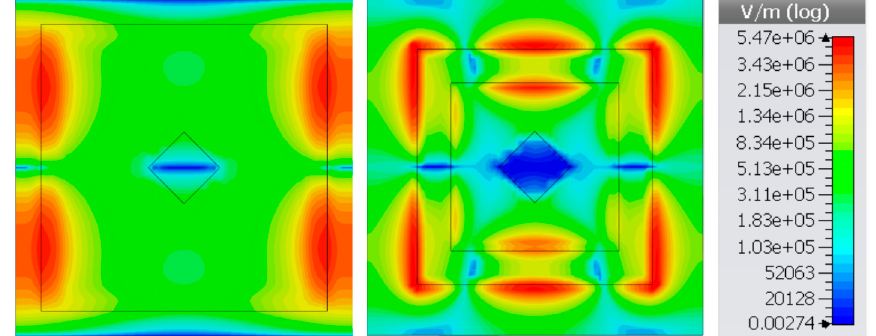
Figure 3. The distributions of the intensity of the electric field calculated just above the MS for the resonance frequencies f 1 without the inner ring ( left ) and f 2 without the outer ring ( right ).